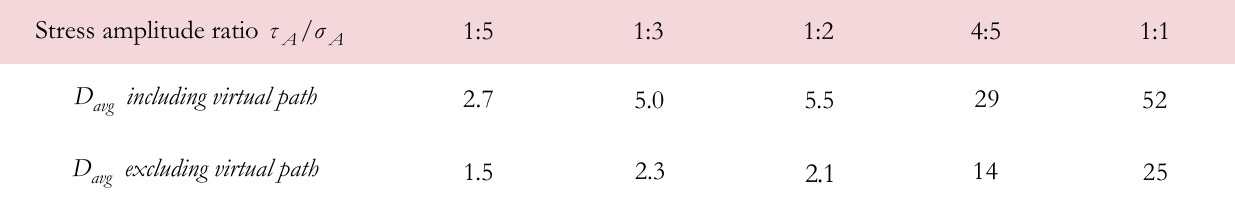
Table 7b: Average fatigue damage obtained with PDMR cycle counting for VA loading; Results normalized with pure tension/bending (i.e. normal stress